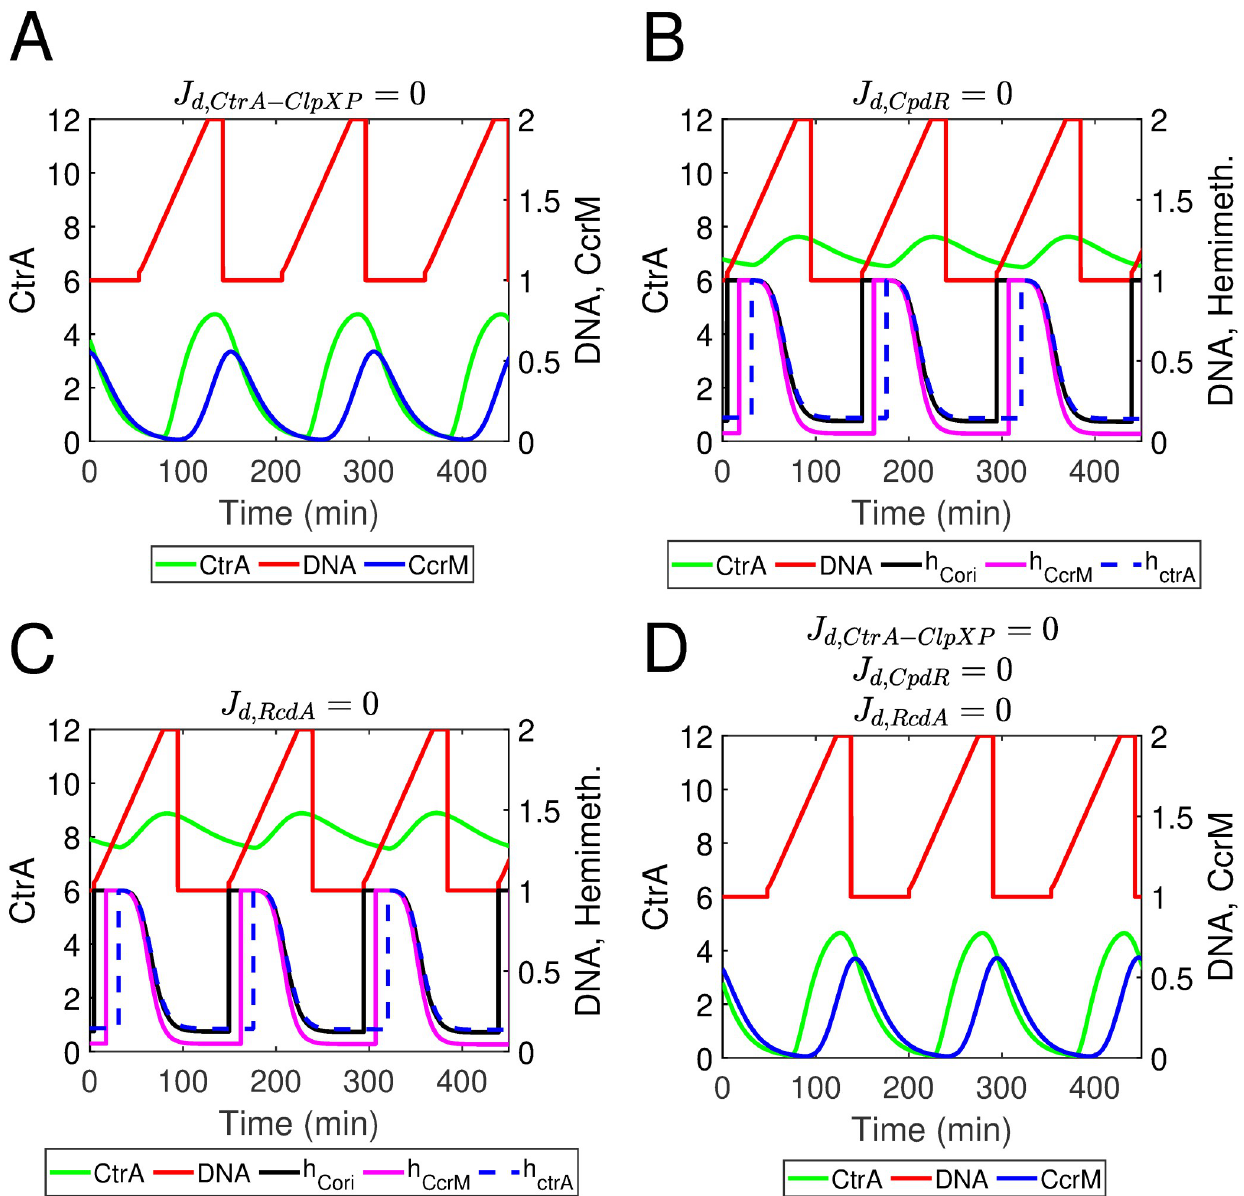
Fig 12. (A-D) Simulated results of mutating the cyclic proteolysis of CtrA, CpdR, or/and RcdA. (A). J d,CtrA is replaced by a constant. (B). J d,CpdR = 0 indicates the cyclic proteolysis of CpdR is replaced by a constant. (C). J d,RcdA = 0 indicates the cyclic proteolysis of RcdA is replaced by a constant. (D). The cyclic proteolysis of CtrA, CpdR, and RcdA are all mutated as constant degradation.